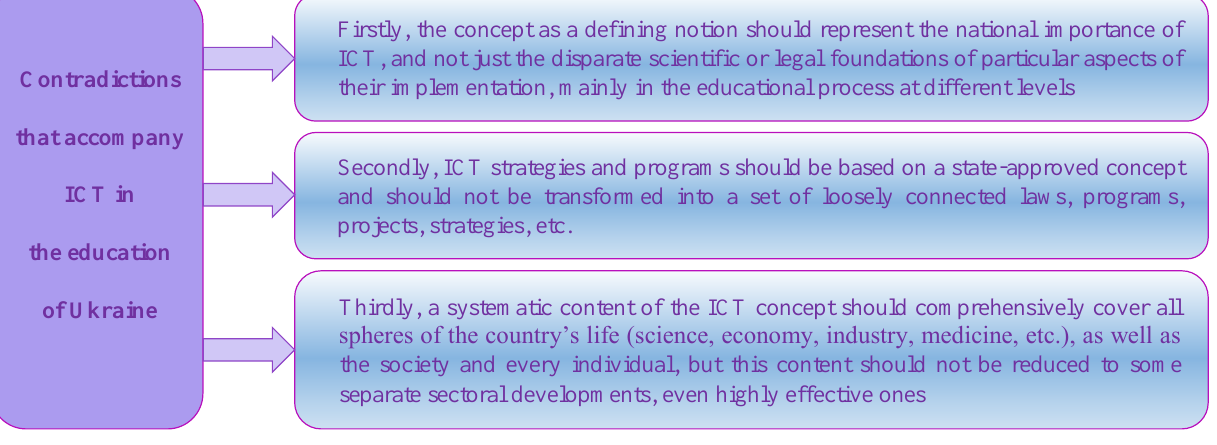
Figure 1. A number of contradictions that accompany ICT in the education of